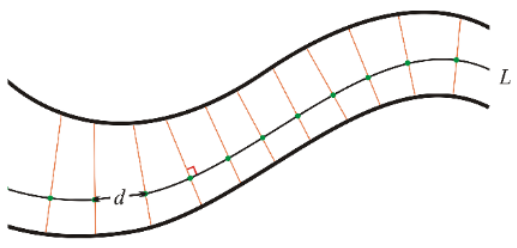
Figure 3. An illustration of sectioning road data.